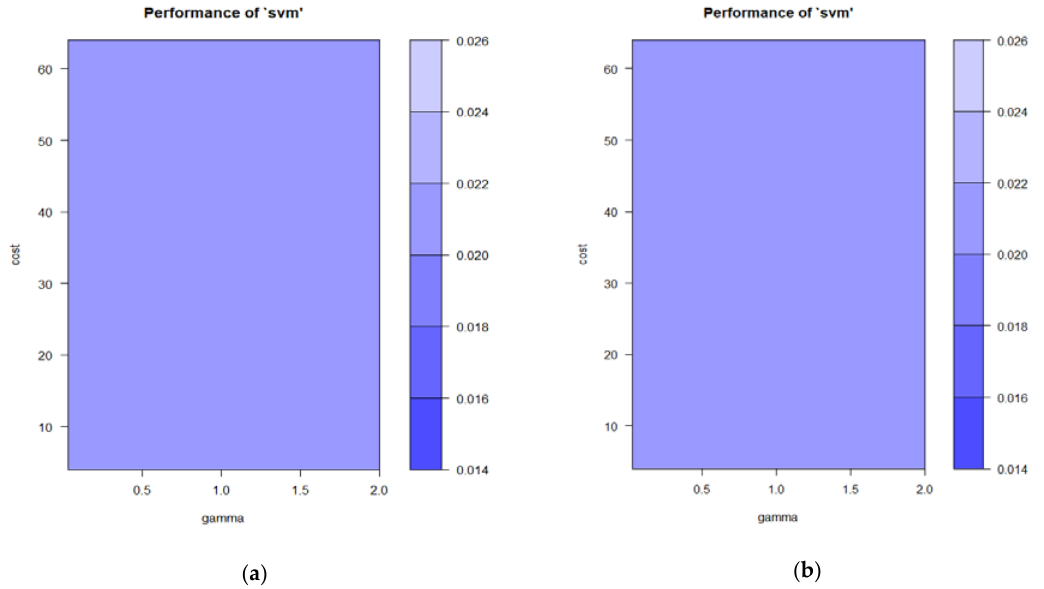
Figure A4. Parameter tuning for the postulated SVM plot: all variables with the moving window and the expanding window methods. ( a ) parameter tuning for the SVM plot of all variables with the moving window method in the final loop calculation; ( b ) parameter tuning for the SVM plot of all variables with the expanding window method in the final loop calculation.